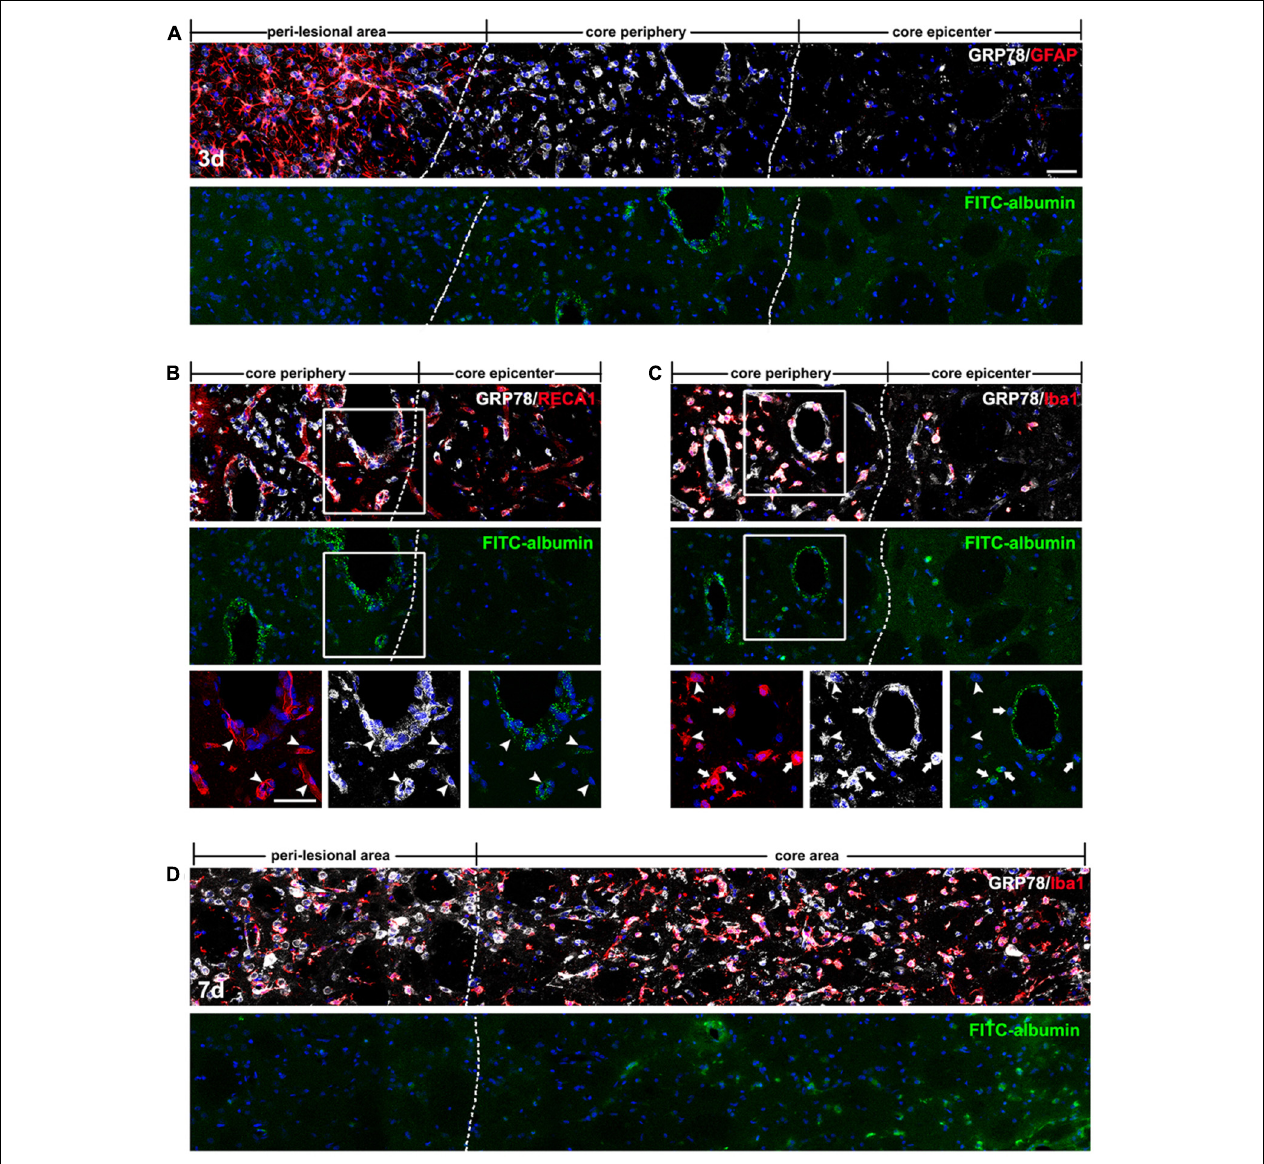
FIGURE 6 | Spatiotemporal coincidence between vascular glucose-regulated protein (GRP78) expression and blood–brain barrier (BBB) leakage, as indicated by extravasation of fluorescein isothiocyanate (FITC)-albumin in the striata lesion by 3-nitropropionic acid injection. (A) Triple-labeling of FITC-albumin, GRP78, and GFAP 3 days after lesion induction, showing that vessels labeled with FITC-albumin are distributed only in the periphery of the lesion core, and not in the peri-lesional area or the lesion epicenter. The two broken lines indicate the borders of the three areas: the peri-lesional area, lesion periphery, and epicenter. (B) Triple-labeling of FITC-albumin, GRP78, and RECA1 at day 3, showing that both FITC-albumin and GRP78 are detectable in nearly identical vessels (arrowheads) in the lesion periphery. (C ) Triple-labeling of FITC-albumin, GRP78, and Iba1 at day 3, showing that in addition to vascular walls, FITC-albumin is detected in amoeboid-like brain macrophages (arrows), but not in activated microglia with evident processes (arrowheads). (D) Triple-labeling of FITC-albumin, GRP78, and Iba1 at 7 days after lesion induction, showing that tracer extravasation is detectable throughout the lesion core (right side of the broken line). Cell nuclei are stained with 4 (cid:48) ,6-diamidino-2-phenylindole. Scale bars represent 50 µ m for A–D